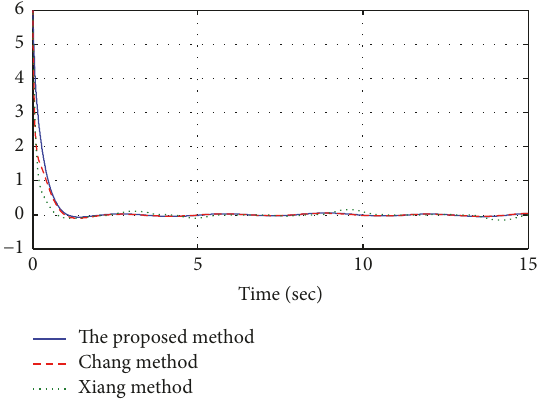
Figure 5: System output 𝑦 2 of the three methods.